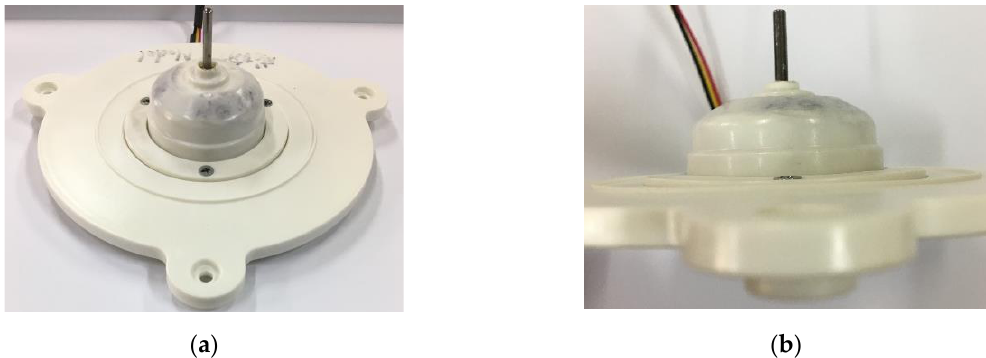
Figure 21. Photograph of the manufactured model: ( a ) top view; ( b ) side view.